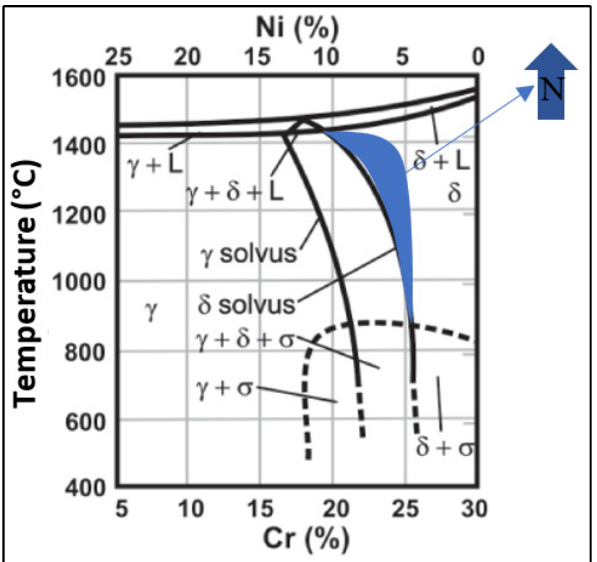
Figure 1. Cr–Ni–68%Fe pseudobinary diagram adapted by the authors [11]. The addition of N 2 expands the biphasic δ + γ field.